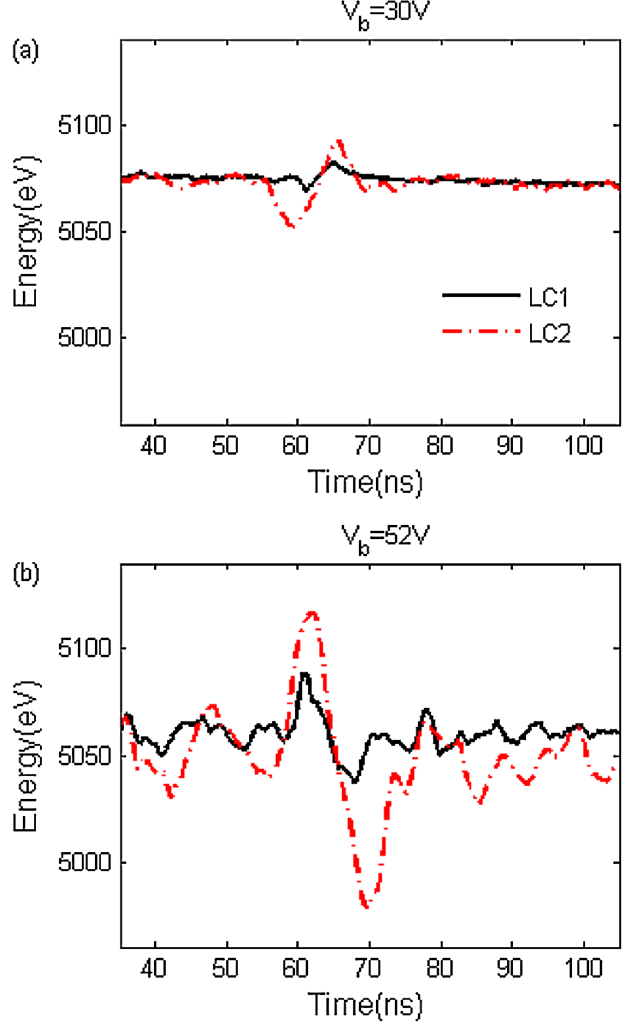
respectively.FIG. 3. (Color) Current profiles of the 4.9 mm beam measured by three Bergoz current monitors when the bias voltage was set to (a) 30 V and (b) 52 V, respectively. In (a), current profiles measured by B2 and B3 are shifted up by 10 and 20 mA, respectively. In (b), current profiles measured by B2 and B3 are shifted up by 20 and 40 mA,